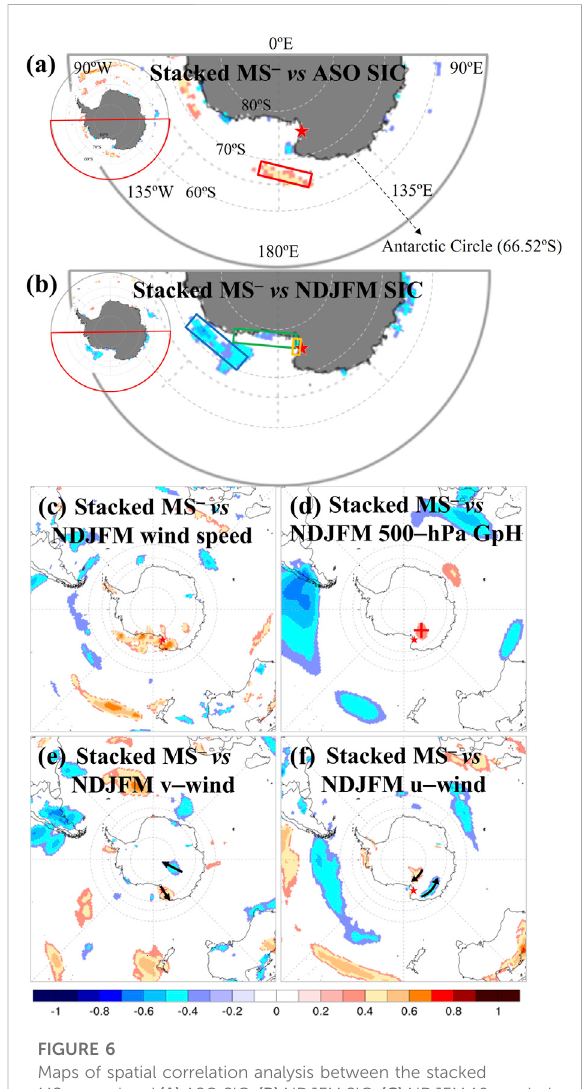
Maps of spatial correlation analysis between the stacked MS – record and (A) ASO SIC, (B) NDJFM SIC, (C) NDJFM 10 m wind speed, (D) NDJFM500 – hPaGpH, (E) NDJFM 10 mv – wind, and (F) NDJFM 10 m u – wind across the Southern Ocean and Antarctica at the 90% signi fi cance level. Red stars represent the locationof theSGP. The fi eldsoftheredline in (A) and blue,green, and orange lines in (B) represent areas of the NRS, the CERS, the RSP, and the TNBP, respectively, for estimating the summertime chlorophyll – a concentrations from satellite images (see SupplementarySectionS1).Theblackarrowsin (E) and (F) arewind vectorsindicatingthedirectionandintensityofthewind.Pearson ’ s correlation coef fi cients on maps are given by the intensity of shading, as displayed in a color scale bar at the bottom. The correlation analysis was performed using the Climate